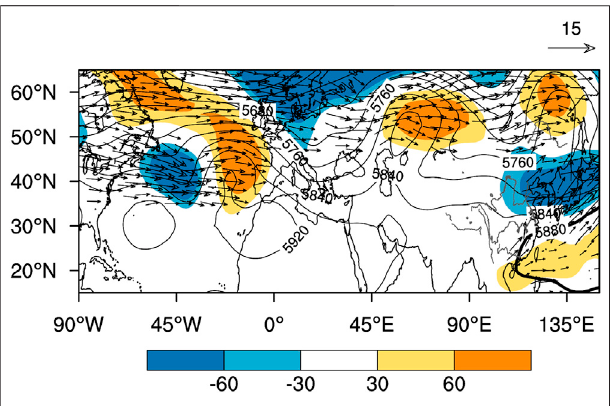
FIGURE 4 | Geopotential height fi eld (contour, unit: gpm), geopotential height anomaly fi eld (colored, unit: gpm) and wave-activity fl ux (arrow,